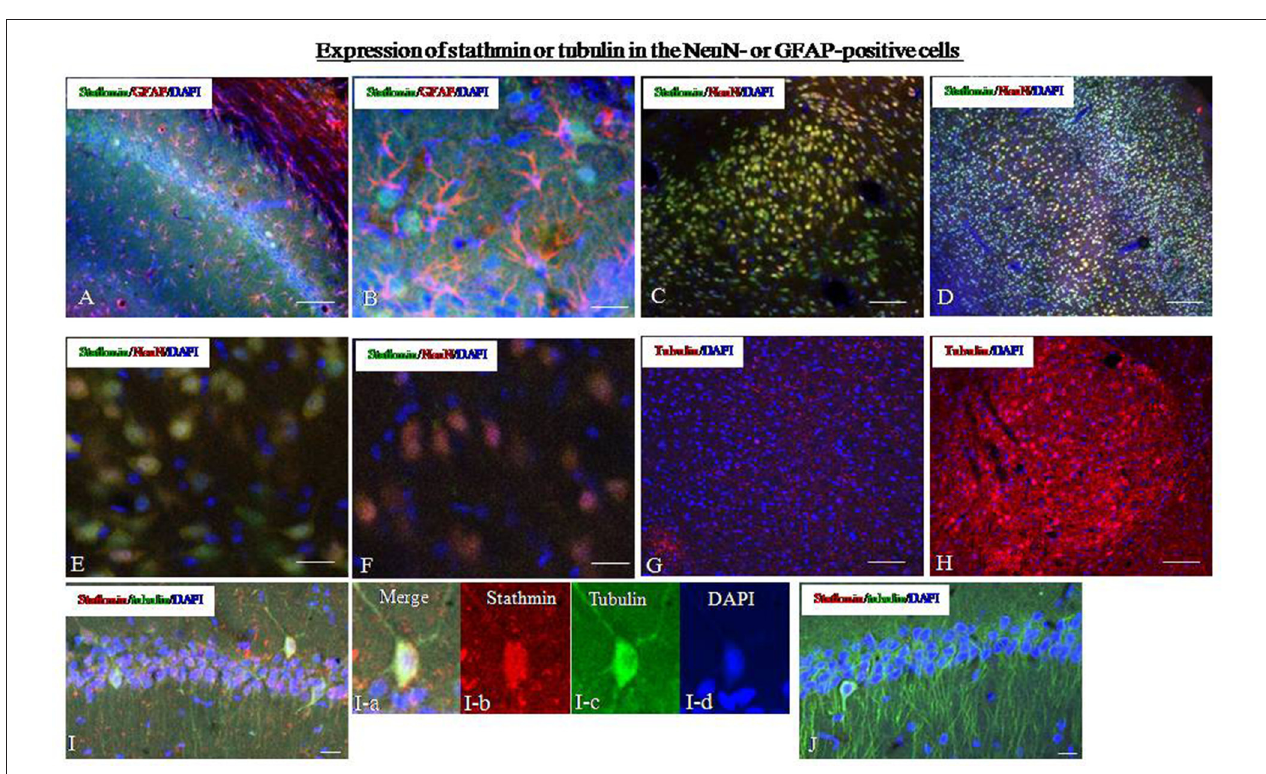
FIGURE 4 | Expression of stathmin and tubulin in the hippocampus. (A) Dual-immunofluorescence image showing stathmin-ir and glial fibrillary acid protein (GFAP)-ir in the hippocampus of the control group. (B) A higher magnification image showing colocalization of stathmin-ir and GFAP-ir in the hippocampus of the control group. (C) Dual-immunofluorescence image showing stathmin-ir and NeuN-ir in the amygdala of the control group. (D) Dual-immunofluorescence image showing stathmin-ir and NeuN-ir in the cingulate cortex of the control group. (E) A higher magnification image showing colocalization of stathmin-ir and NeuN-ir in the amygdala of the control group. (F) A higher magnification image showing decreased stathmin in the amygdala of the SPS group. (G,H) Expression of tubulin in the amygdala of the control group (G) and the SPS group (H) . (I,J) Colocalization of stathmin- and tubulin-ir in the hippocampal CA1 region of control (I) and SPS group (J) . The magnification image of colocalzation of stahtmin- and tubulin-ir were showed in the I-a (merge), I-b (stathmin), I-c (tubulin0 and I-d (DAPI; ∗ P < 0.05 vs. the control group; Bar in ( B,D–F,I,J : 100 µ m; Bar in A,C,G,H : 20 µ m).